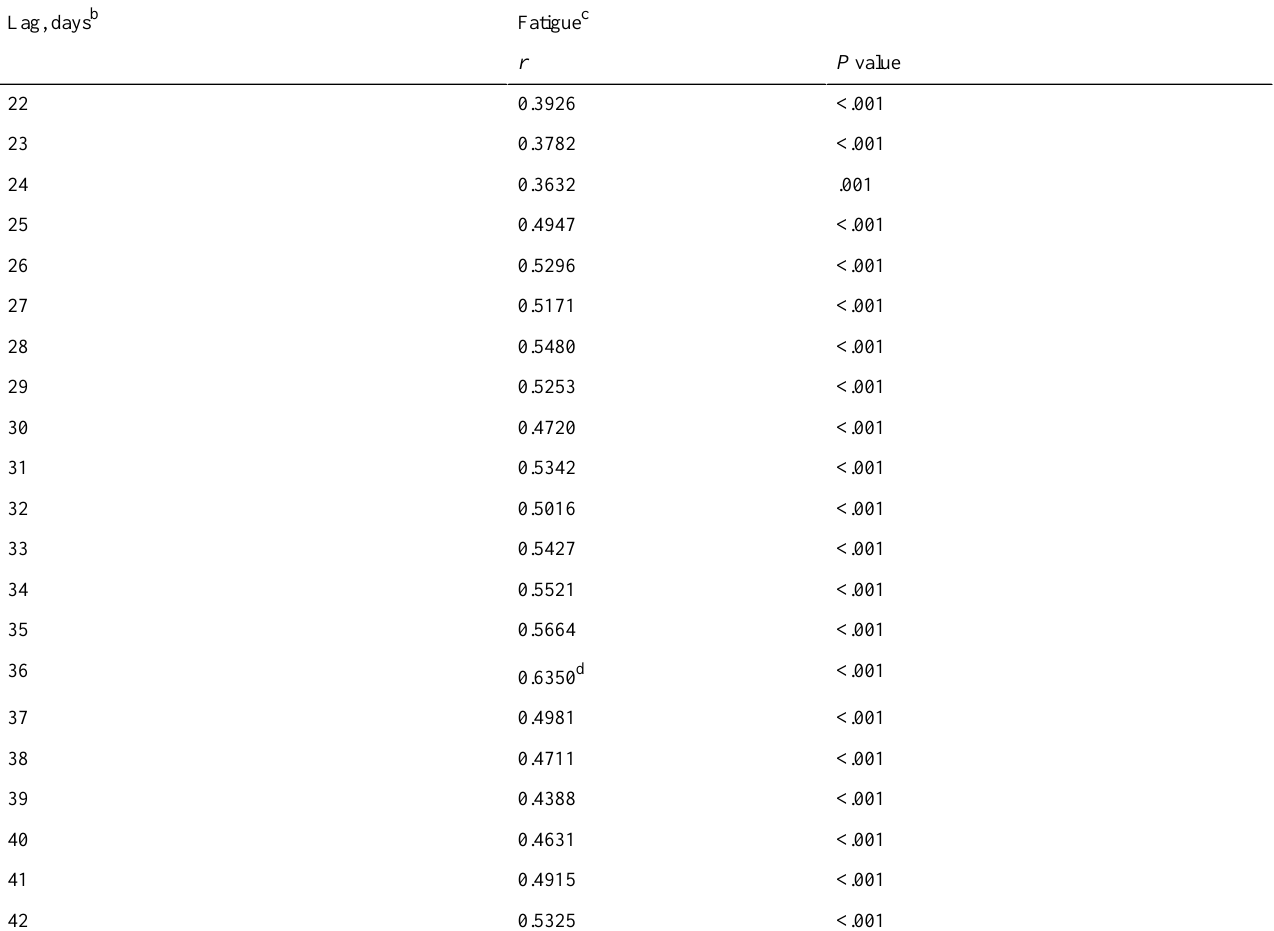
Table 3. Pearson correlation coefficients and P values for the search term “fatigue.” Time lags with respect to COVID-19 incidence data are also presented a .